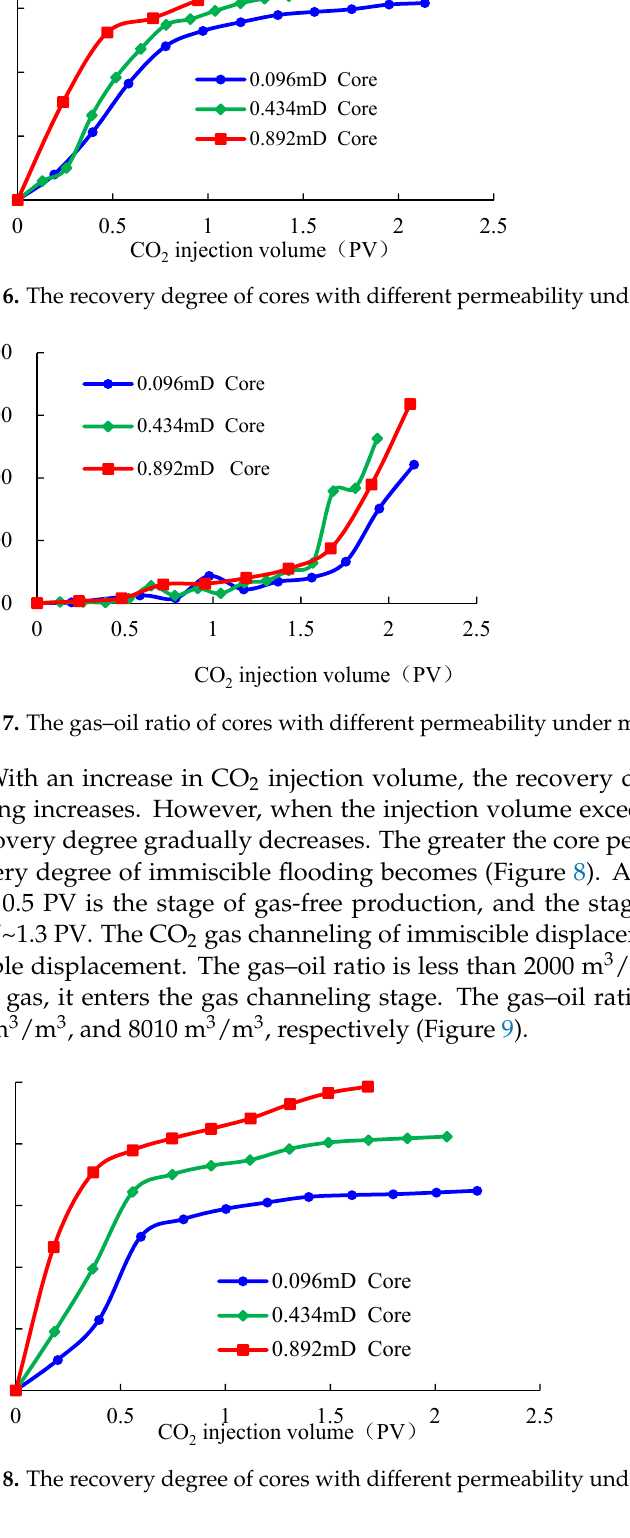
Figure 9. The gas–oil ratio of cores with different permeability under immiscible conditions. Before CO 2 breakthrough, the main oil displacement mechanisms are dissolved gas drive, CO 2 extraction, and volume expansion. The mass transfer and extraction of CO 2 are enhanced, with a reduction in the interfacial tension. In addition, more gas enters the small pores, and unlocks crude oil in the small pores. The viscosity of crude oil is reduced and then increases the oil mobility. After CO 2 breakthrough, due to the formation of a gas- channeling channel, carbon dioxide forms a fingering phenomenon in the displacement process, resulting in the reduction of oil recovery. Therefore, the development of tight sandstone reservoir by carbon dioxide injection and the improvement of miscibility are conducive to the improvement of oil recovery. 4.2. Analysis of Experimental Results of Water Drive to Gas Drive (1) Oil displacement of 0.45 mD core When the injection pressure of the core is 20 MPa, and the outlet pressure is 15 MPa, the oil displacement potential of water injection to CO 2 injection in 0.45 mD core is studied. With an increase in injected water volume, the recovery degree of crude oil increases. Af- ter 1.02 PV water is injected into the core, the water content reaches 91.2%, and the recov- ery factor is 38.21%. When the core was alternated to CO 2 flooding, the water cut began to